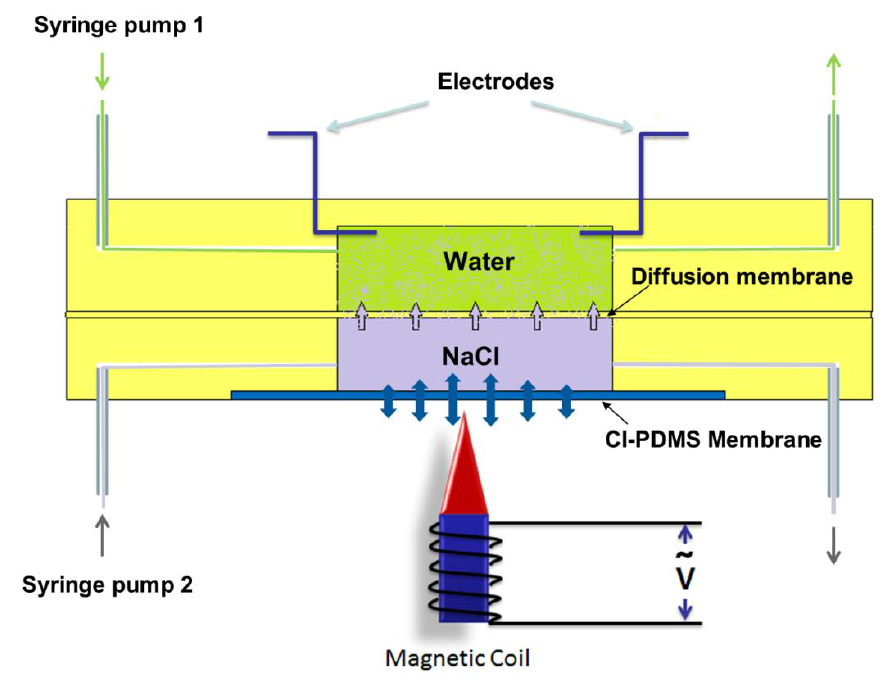
Figure 4. Cross-sectional view of a microfluidic device for chemical release. Reproduced with permission from